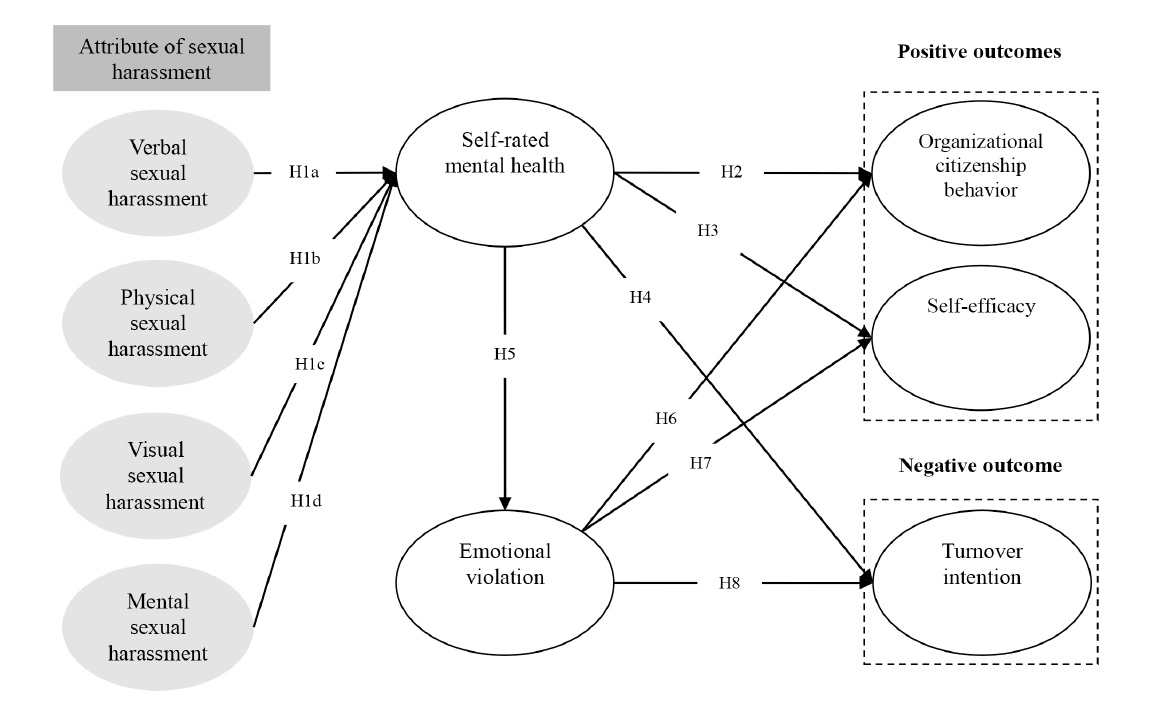
Fig. 1. The proposed conceptual